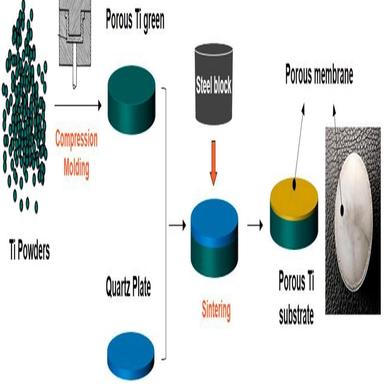
Schematic of preparation process.